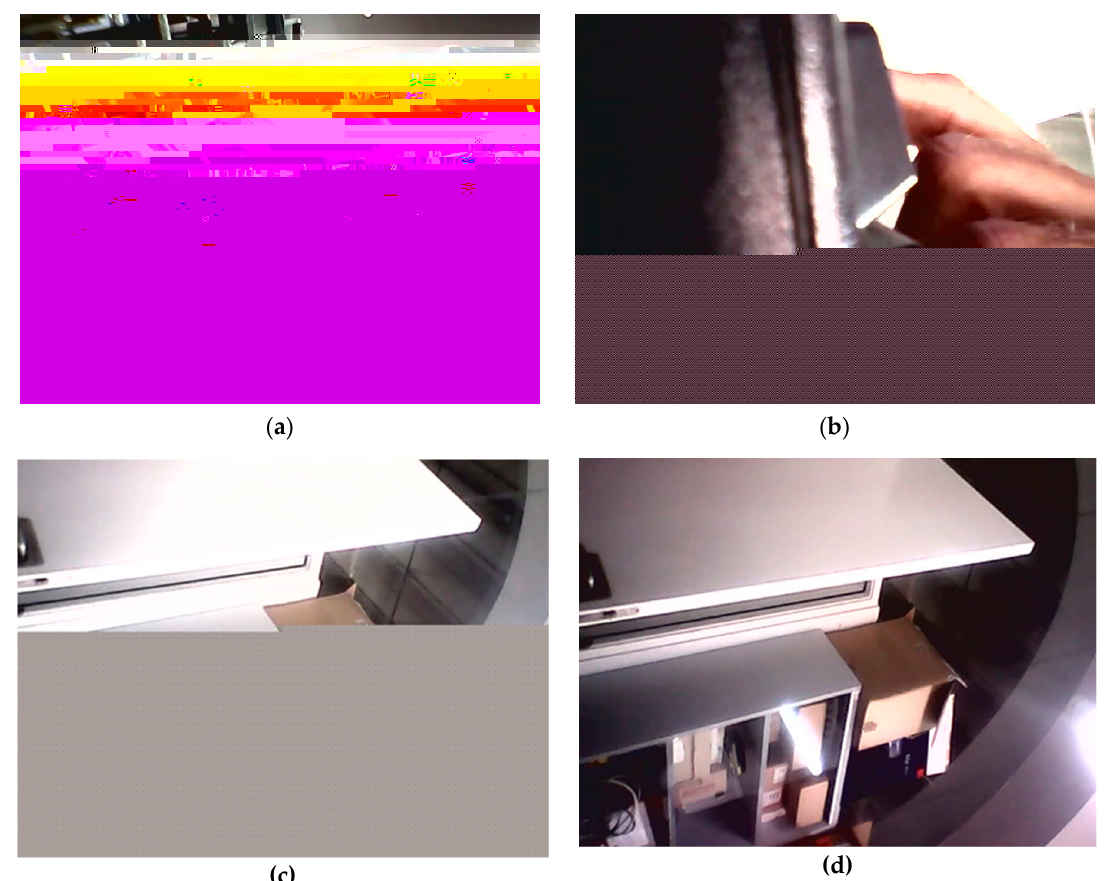
Figure 10. Some sample images received in the coordinator node with different transmission speeds: ( a ) 57,600 bps; ( b ) 38,400 bps; ( c ) 28,800 bps; ( d ) 19,200 bps (image received without errors).